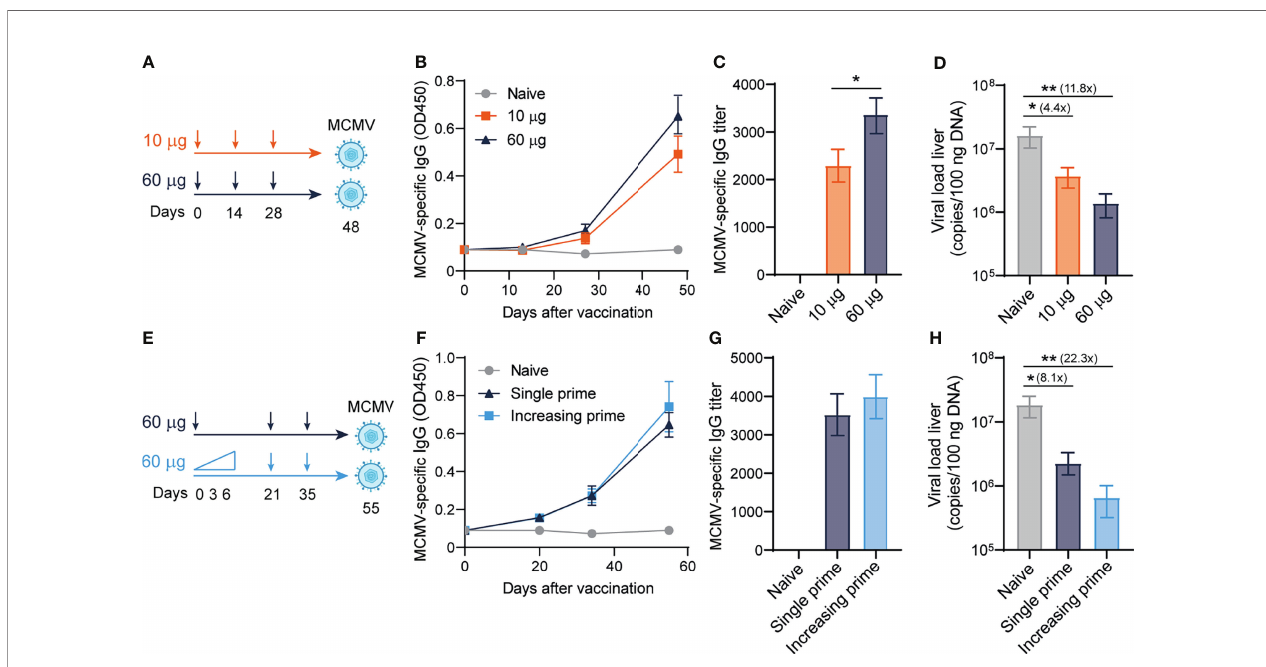
FIGURE 2 | Dose-escalating DNA-based vaccination improves antibody responses and viral protection. (A) Vaccination schedule for mice were vaccinated intradermally three times with different doses (10 ug and 60 ug) of the sgB DNA vaccine. Three weeks after the fi nal vaccination, mice were challenged intraperitoneally with 5 × 10 4 PFU salivary gland-derived MCMV-Smith. (B) Kinetic analysis of the MCMV-speci fi c IgG response in serum. Data shown are mean values ± SEM (n=8) (C) MCMV-speci fi c endpoint binding IgG titers after three vaccinations. Data shown are mean values ± SEM (n=8). One-way ANOVA was used for statistical analysis. (D) At day 4 post-infection, livers were isolated and the viral genome copies were determined by PCR. The viral load is depicted as mean values ± SEM (n=8). (E) Vaccination schedule for mice vaccinated intradermally with either an increasing dose prime schedule (10 µg on day 0, 20 µg on day 3 and 30 µg on day 6) or a single prime dose of 60 µg on day 0, followed by two booster immunizations with a high dose (60 µg) of the sgB DNA vaccine. Three weeks after the fi nal vaccination, mice were challenged intraperitoneally with 5 × 10 4 PFU salivary gland-derived MCMV-Smith. (F) Kinetic analysis of the MCMV-speci fi c IgG response in serum. Data shown are mean values ± SEM (n=8) (G) MCMV-speci fi c endpoint binding IgG titers after two booster vaccinations are shown and represent mean values ± SEM (n=8). One-way ANOVA was used for statistical analysis. (H) At day 4 post-infection, livers were isolated and the viral genome copies were determined by PCR. The viral load is depicted as mean values ± SEM (n=8). Experiments were performed twice with similar outcome. A Kruskal-Wallis test was used for statistical analysis. *P<0.05,